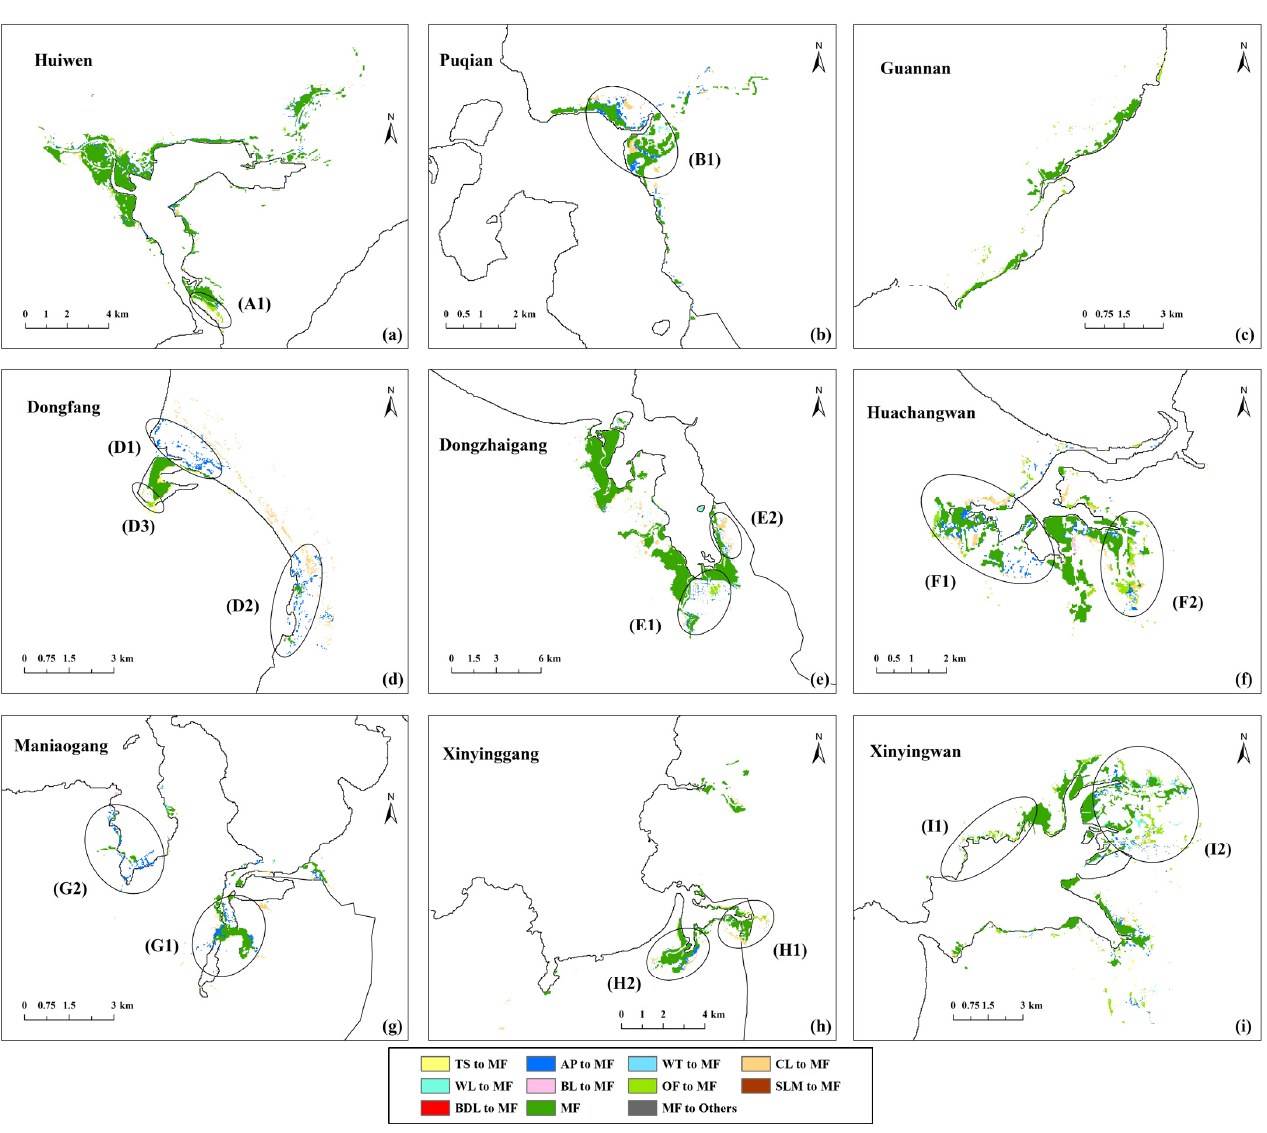
Figure 10. Land cover changes of mangrove forests ( a )–( i ) from 2017 to 2037 under MPS.